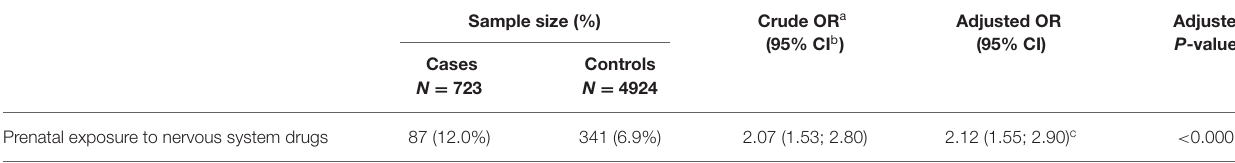
TABLE 6 | Gross and adjusted odds ratio calculated to compare prenatal nervous system drug exposure between the case and control